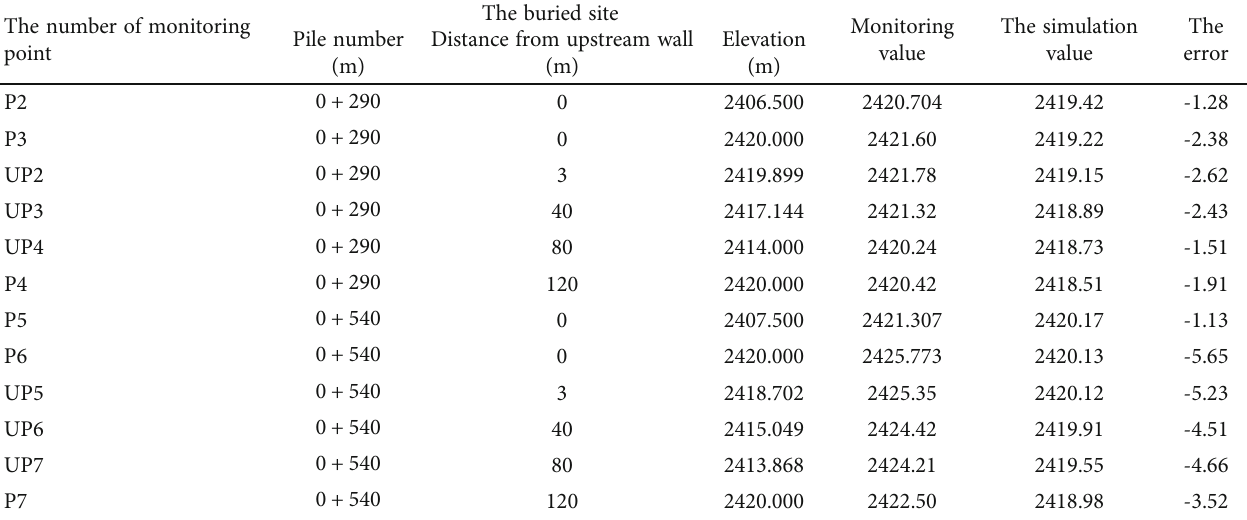
Table 4: The comparison of seepage pressure at downstream dam body.